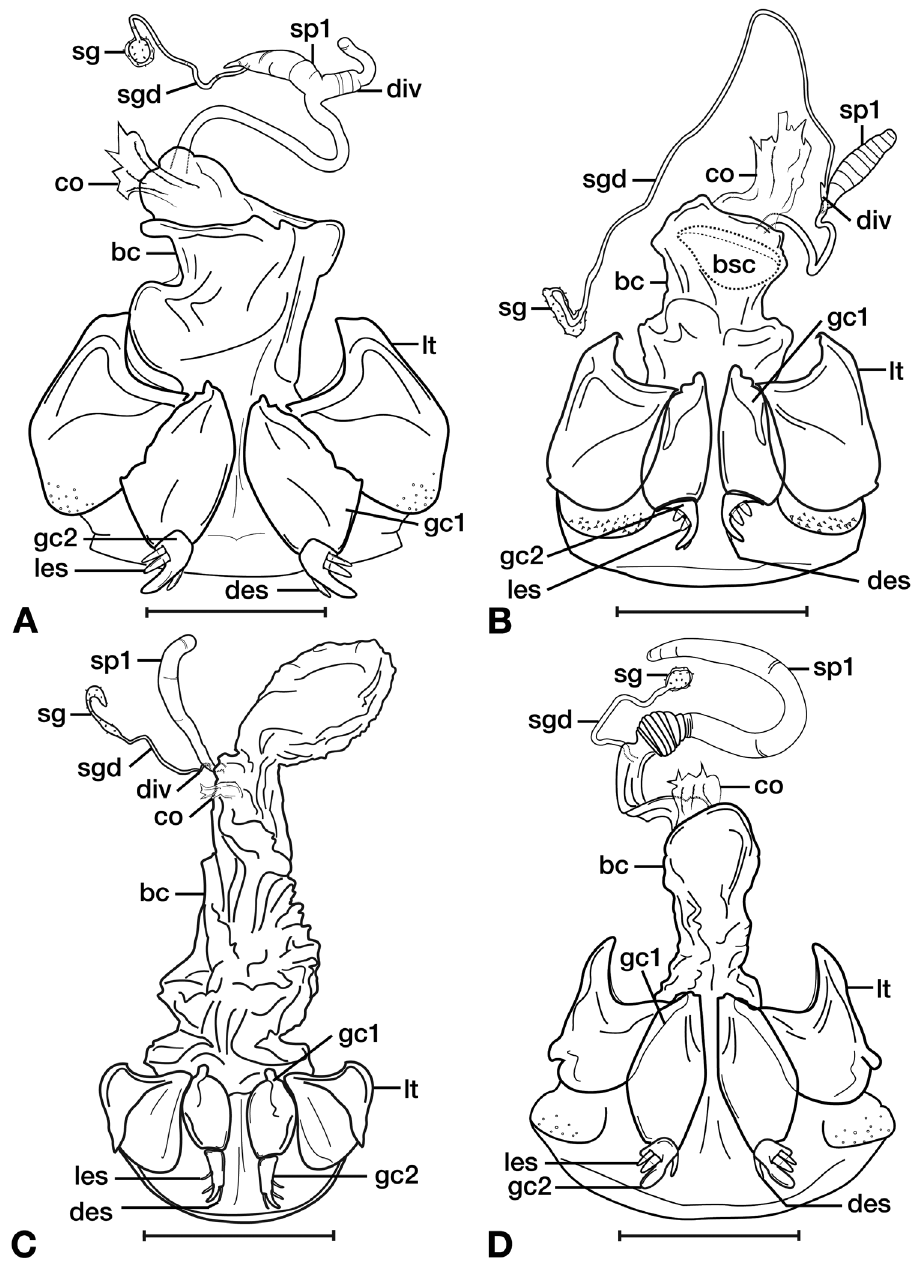
Figure 94. Line drawings of the female reproductive tract, ventral aspect, of A Holcoderus formosanus Jedlička B Horniulus andrewesi Jedlička C Lioptera erotyloides Bates D Miscelus javanus Klug. Legend: bc bursa copulatrix; bsc bursal sclerite; co common oviduct; des dorsal ensiform setae; div diverticulum gc1 gonocoxite 1; gc2 gonocoxite 2; les lateral ensiform setae; lt lateral tergite; sg spermathecal gland; sgd spermathecal gland duct; sp1 spermatheca 1 . Scale bars: 0.5